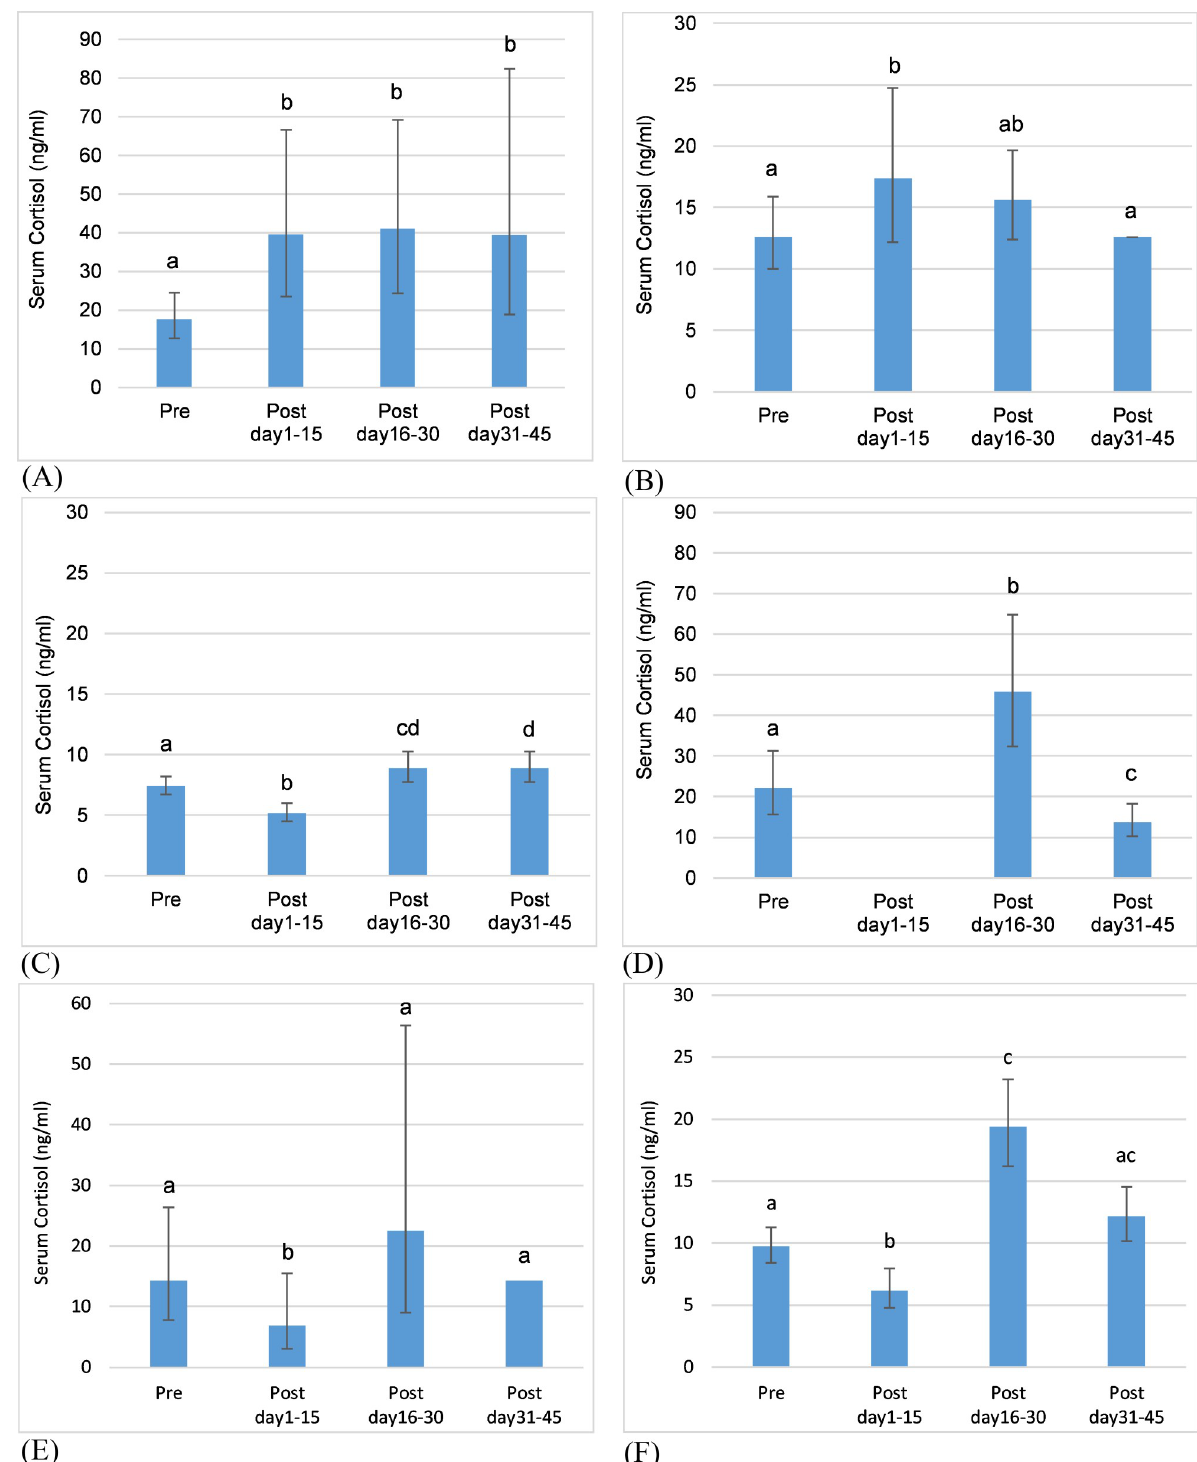
Fig 4. Death of a herdmate as a predictor of adrenal GC activity. Predictions from GLMMs for cortisol concentration comparing mean values in the 30 days prior to death and the 45 days post-death in 15-day time blocks (error bars represent standard error of the prediction). Letters denote significant differences in mean values across time periods. (A) Death 1, F2OZ response: Post > Pre in 15-day time periods post death; values remained above pre-event concentrations for at least 45 days. (B) Death 1, F3OZ response: Post > Pre in first 15 days post death; values returned to